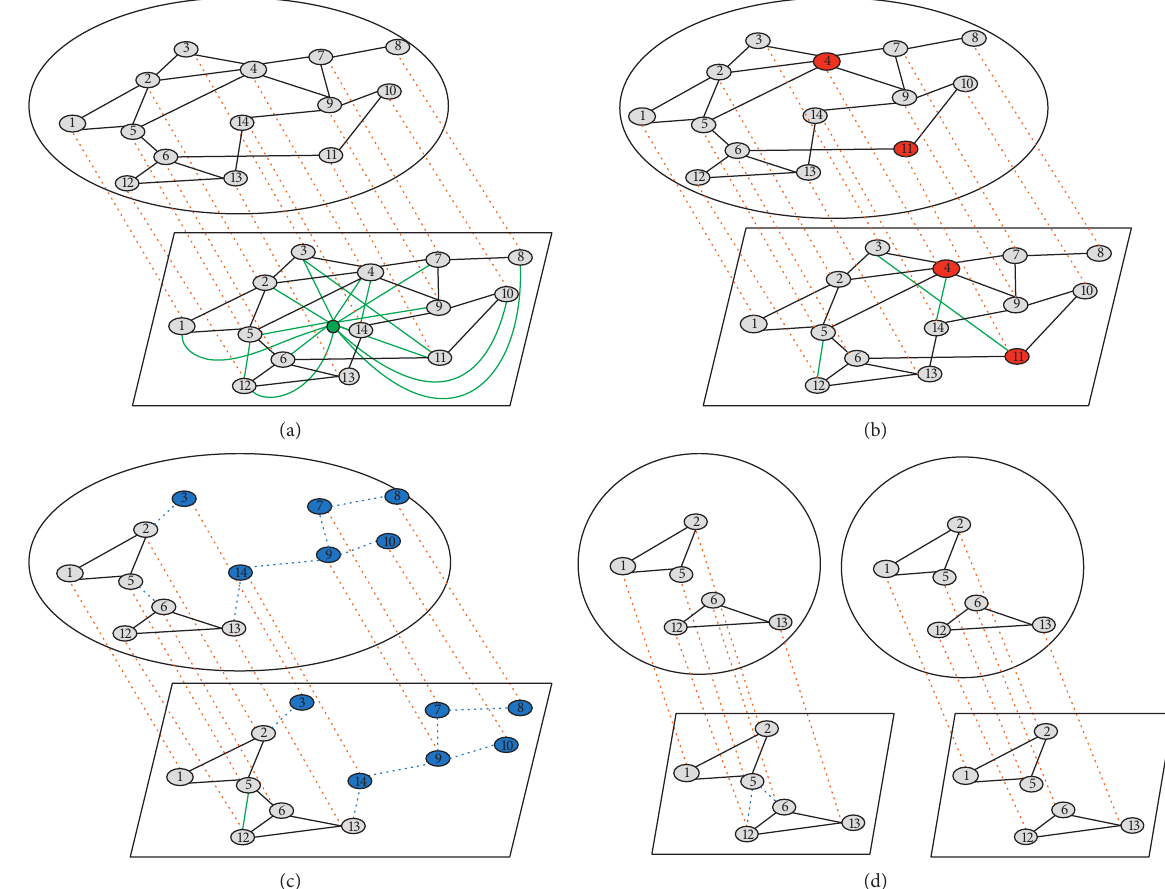
Figure 5: Cascading failure behaviors of the power interdependent network.